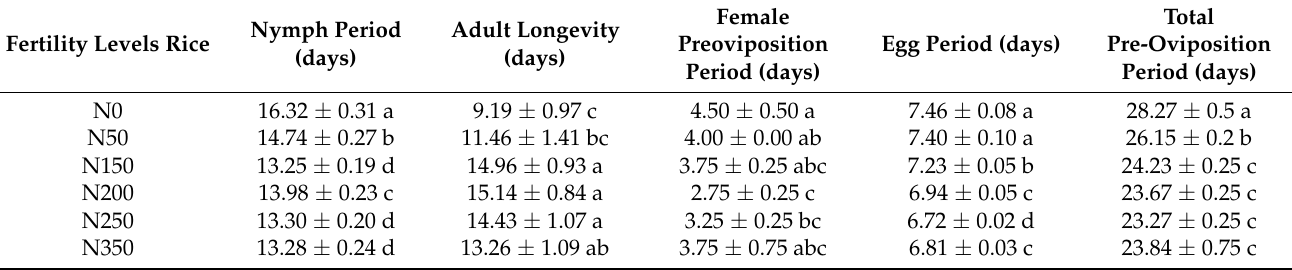
Values are means ± standard error (SE). Different letters following the means in the same column denote significant difference at p < 0.05 via LSD multiple range tests. N0, N50, N150, N200, N250, and N350 represent the rice plants grown from the six fertility levels (0, 50, 150, 200, 250, and 350 kg/ha), respectively. Total pre-oviposition period is the duration from egg to first